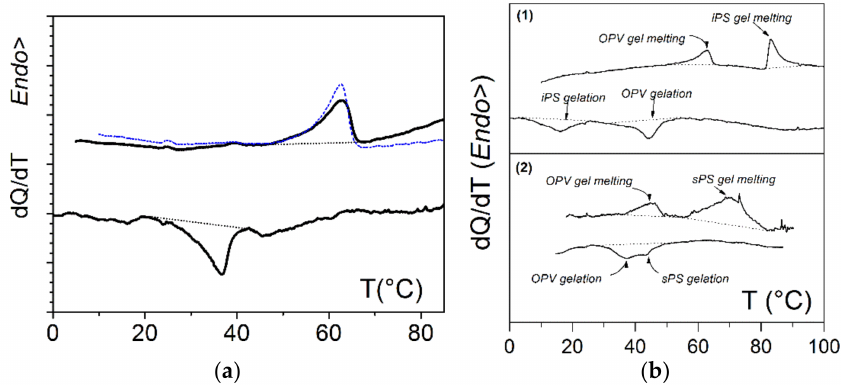
Figure 2. DSC thermograms; ( a ): the OPVOH organogel formation and melting, in blue the gel melting in the ternary system OPVOH/aPS/benzene, where C aPS = 2.5 × 10 − 2 g/cm 3 and C OPVOH = 0.4 × 10 − 2 g/cm 3 ; ( b ) ternary gels: (1) isotactic polystyrene/OPVOH in trans -decahydronaphthalene; (2) syndiotactic polystyrene/OPVOH in benzene, where C polymer = 7 × 10 − 2 g/cm 3 and C OPVOH = 0.4 × 10 − 2 g/cm 3 (data from Dasgupta et al. [10]). For details, see text.